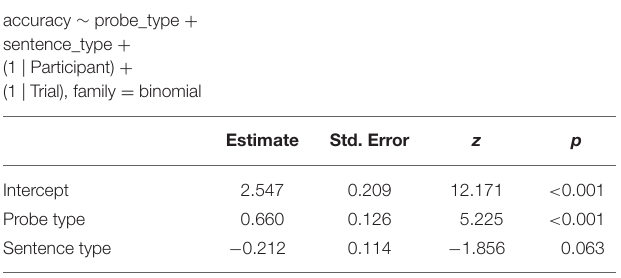
TABLE 3 | The specification and parameter estimates of the best fitting model predicting accuracy in the different probe conditions in Experiment 1. accuracy ∼ probe_type + sentence_type